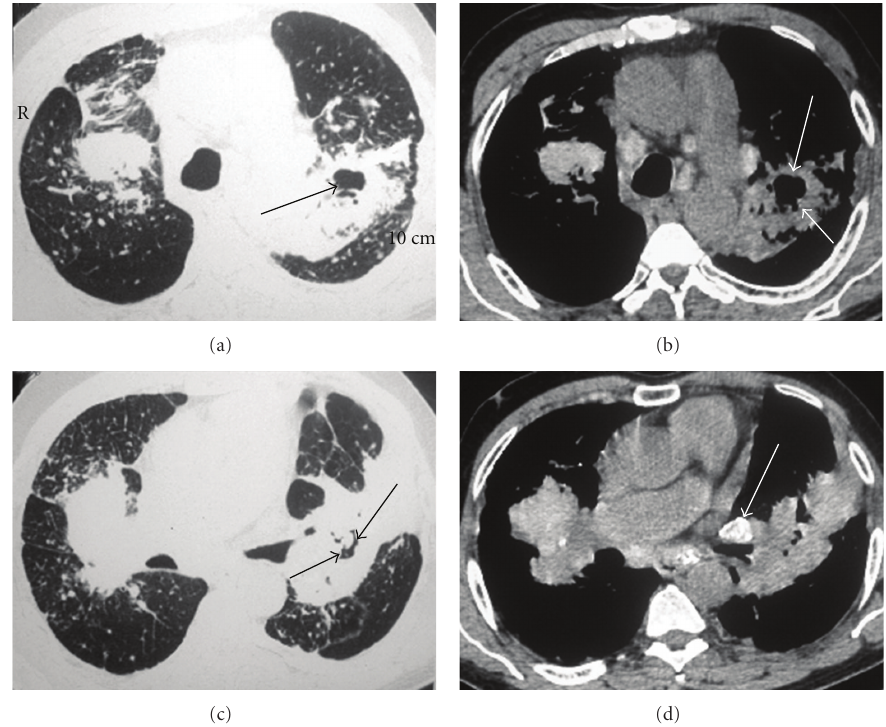
Figure 2: HRCT scan with pulmonary windows ((a) and (c)) showing conglomerate mass (progressive massive fibrosis) with adjacent small nodules in both lungs. Note that the left conglomerate mass presented with a cavitation (arrows). Areas of emphysema and an enlargement of the pulmonary artery trunk are seen. Mediastinal windows ((b) and (d)) also show calcifications in the hilar and mediastinal lymph nodes. Foci of calcification are present in the conglomerate